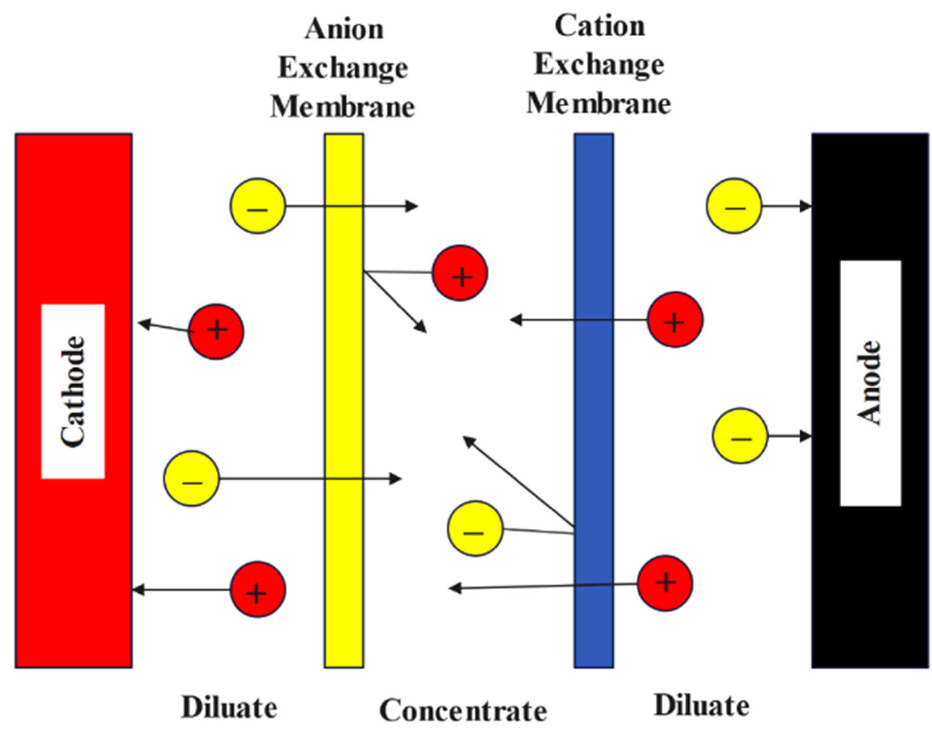
Figure 3. Electrodialysis technique [78] .